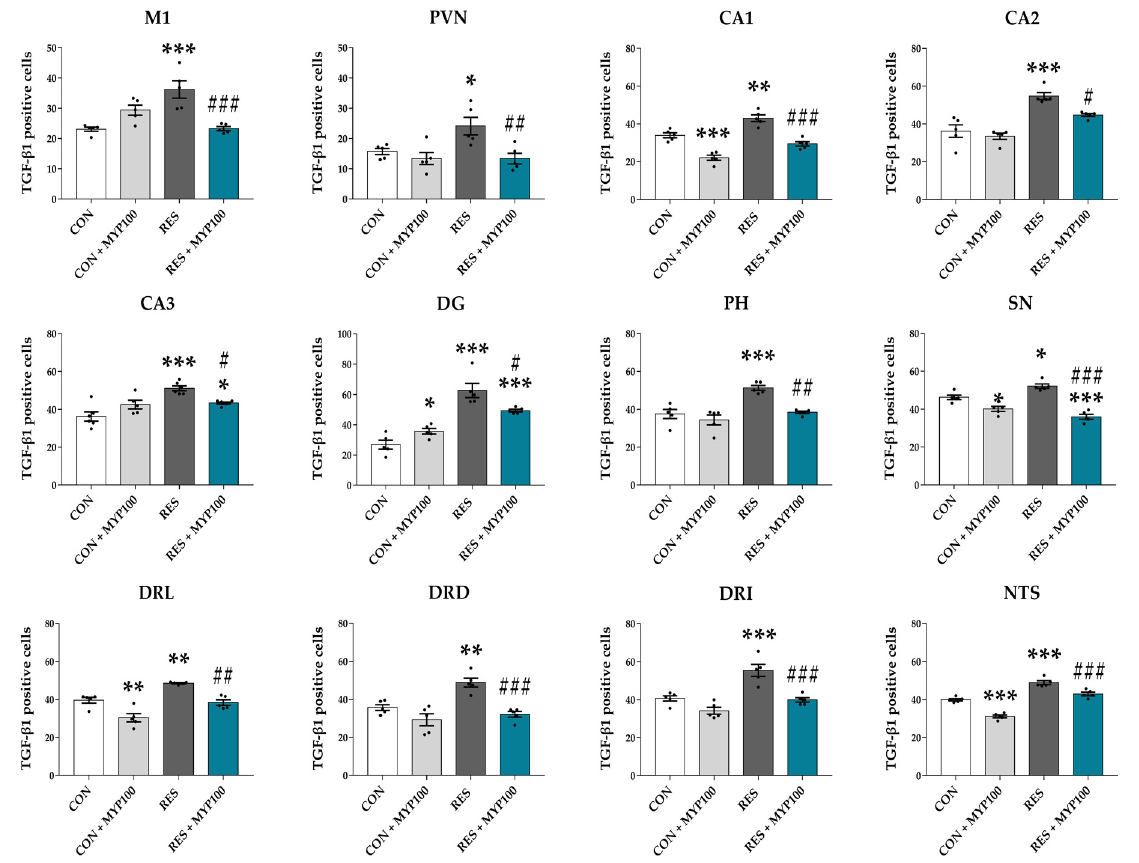
Figure 8. Inhibition of TGF- β expression in each brain region by myelophil (MYP) treatment. The number of TGF- β 1 positive cells in the motor cortex area 1 (M1), paraventricular nucleus (PVN), cornu ammonis area (CA) 1, CA2, CA3, and dentate gyrus (DG) of hippocampus, posterior hypothalamic area (PH), substanitia nigra (SN), lateral part of the dorsal raphe nucleus (DRL), dorsal part of the dorsal raphe nucleus (DRD), interfascicular part of the dorsal raphe nucleus (DRI), and nucleus of solitary tract (NTS) regions was significantly decreased by 100 mg/kg MYP treatment. CON: control ( n = 5), CON + MYP100: 100 mg/kg MYP treatment ( n = 5), RES: 2 mg/kg of reserpine treatment ( n = 5), RES + MYP100: 2 mg/kg of reserpine followed by 100 mg/kg of MYP treatment ( n = 5). Data are expressed as means ± SEM. One-way ANOVA test with Tukey post hoc tests was executed. * p < 0.05, ** p < 0.01, *** p < 0.001 vs. CON; # p < 0.05, ## p < 0.01, ### p < 0.001 vs. RES.